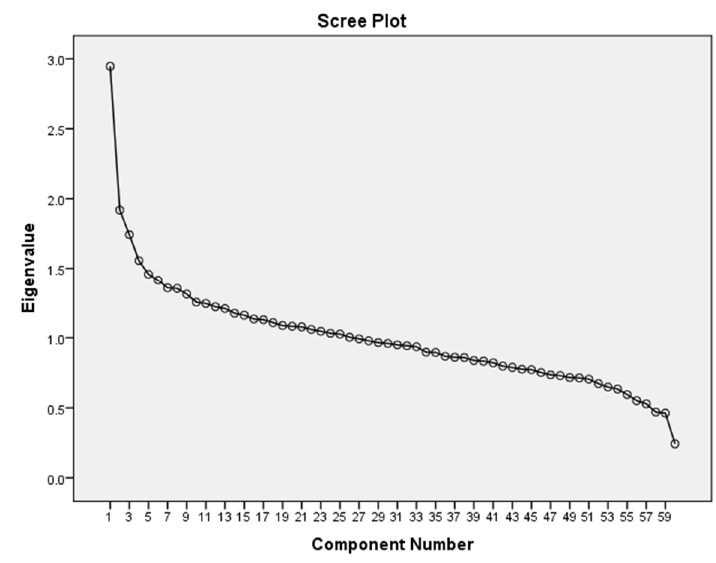
Figure 1. Scree plot for Principal Component Analysis of 60 food variables (National Diet and Nutrition Survey 2008–2012). Table 1. List of UK National Diet and Nutrition Survey (NDNS) food variables included in the principal components analysis (PCA). PUFA: polyunsaturated fatty acids.